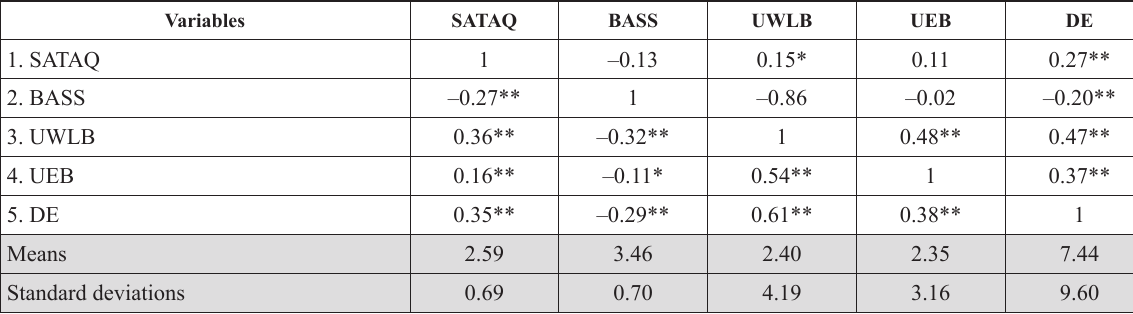
Table 4. Intercorrelations (Pearson’s correlation rate), means, and standard deviations of